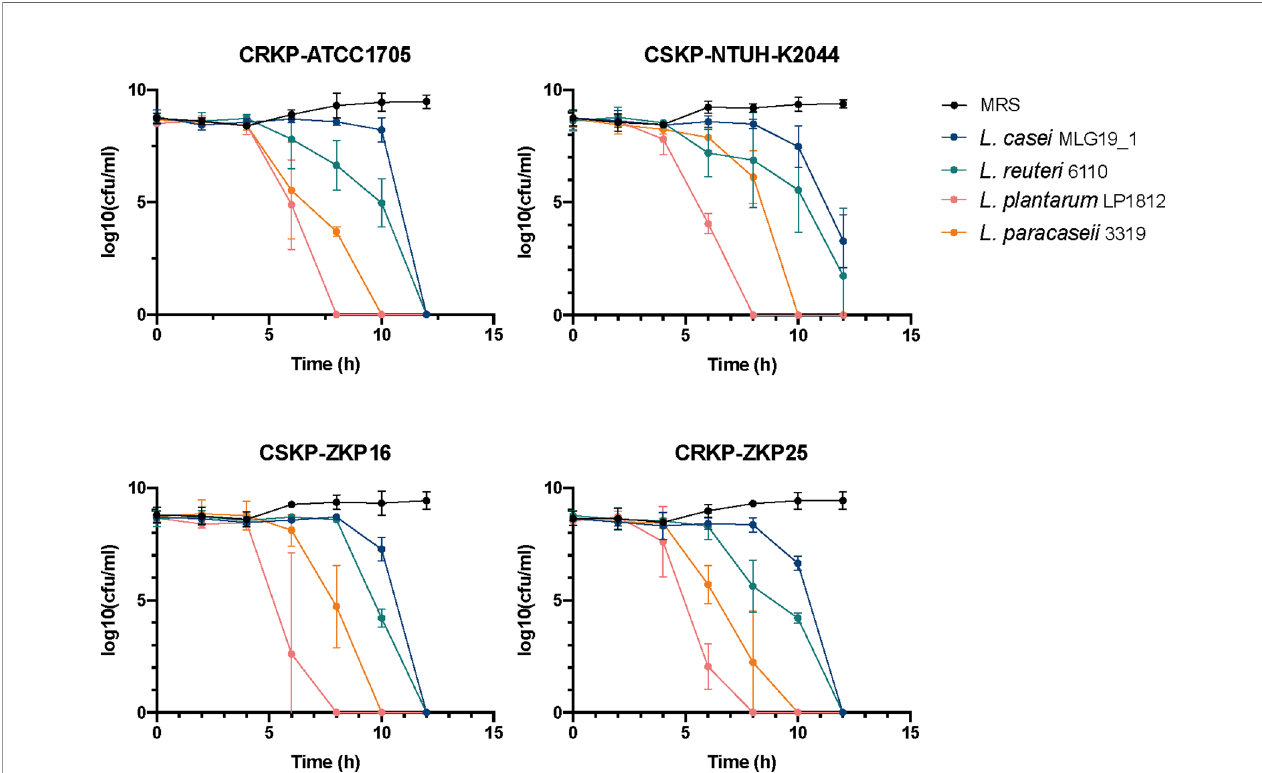
FIGURE 1 | The effects of co-culture trails of K. pneumoniae. and Lactobacillus spp. NTUH-K2044, a classical hypervirulent K. pneumoniae isolate, ATCC1705, a standard carbapenem-resistant K. pneumoniae isolate, ZKP16, a carbapenem-sensitive clinical isolate, ZKP25, a carbapenem-resistant clinical